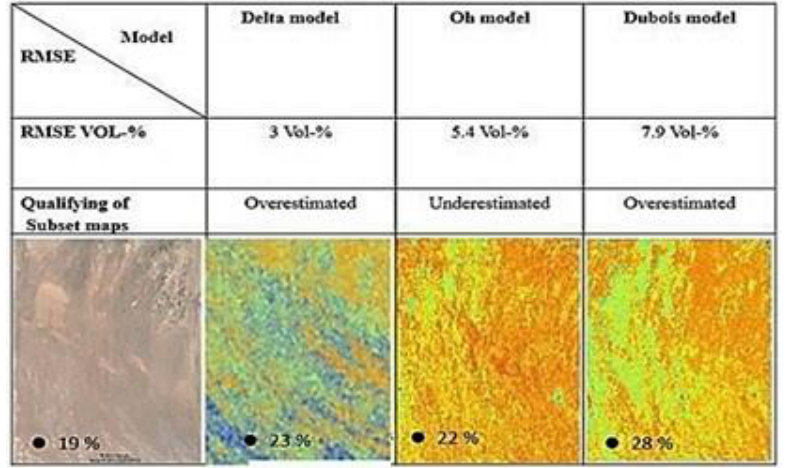
Figure 13. The comparison of soil moisture results of the study area by different methods against the field soil moisture measurement (Vol%) showed in the points.